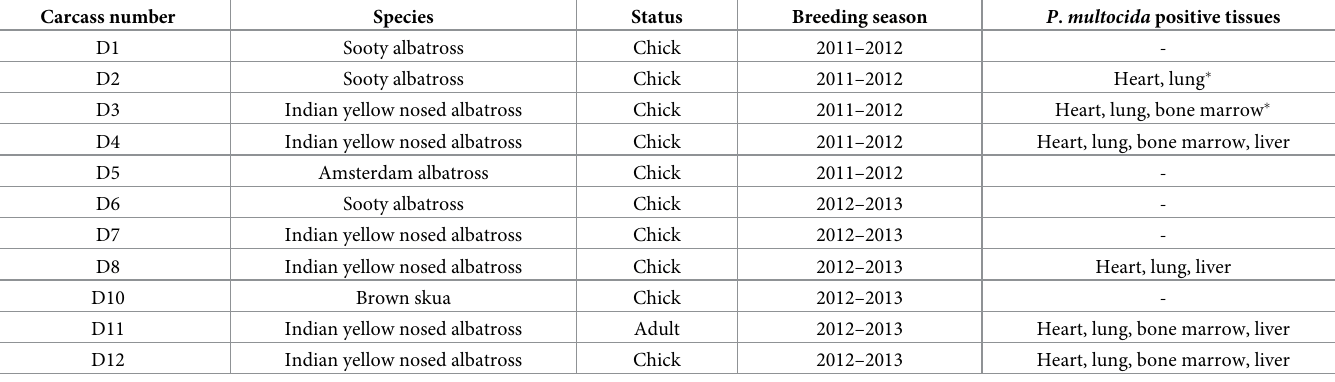
Table 2. Pasteurella multocida positive cultures obtained from heart, lung, bone marrow and liver from 11 seabird carcasses. All culture plates harbored a single, identical morphospecies, except for those two indicated by an asterisk. Carcass